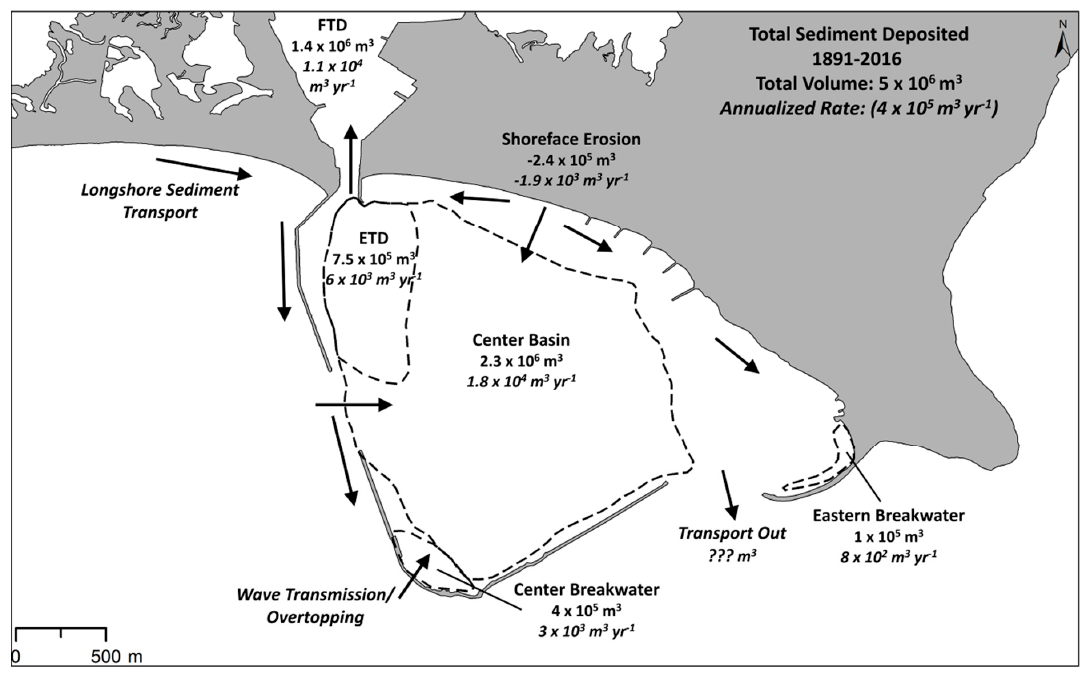
Figure 12. Semi-conceptual sediment budget for the Point Judith Harbor of Refuge. Total deposition between 1891 and 2016 and inferred minimum longshore sediment transport from the adjacent RISS.